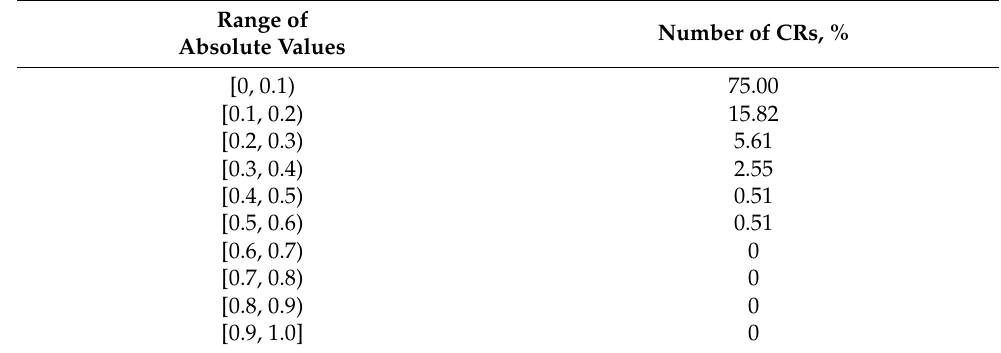
Table 1. The Numbers of CRs, whose absolute values of KRCC are in the Distinguished Ranges (in Percentage of all the Considered CRs).